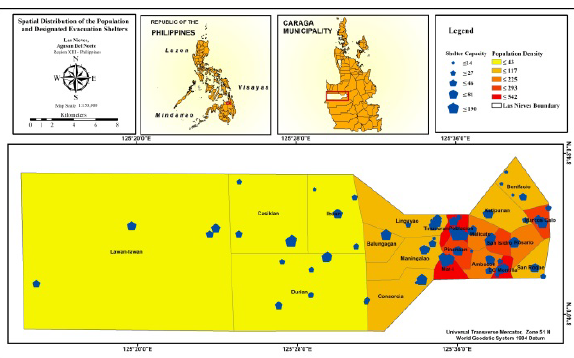
Figure 7. Distribution of Population and Designated Evacuation Shelters with a Standard Capacity of 5 meters squared